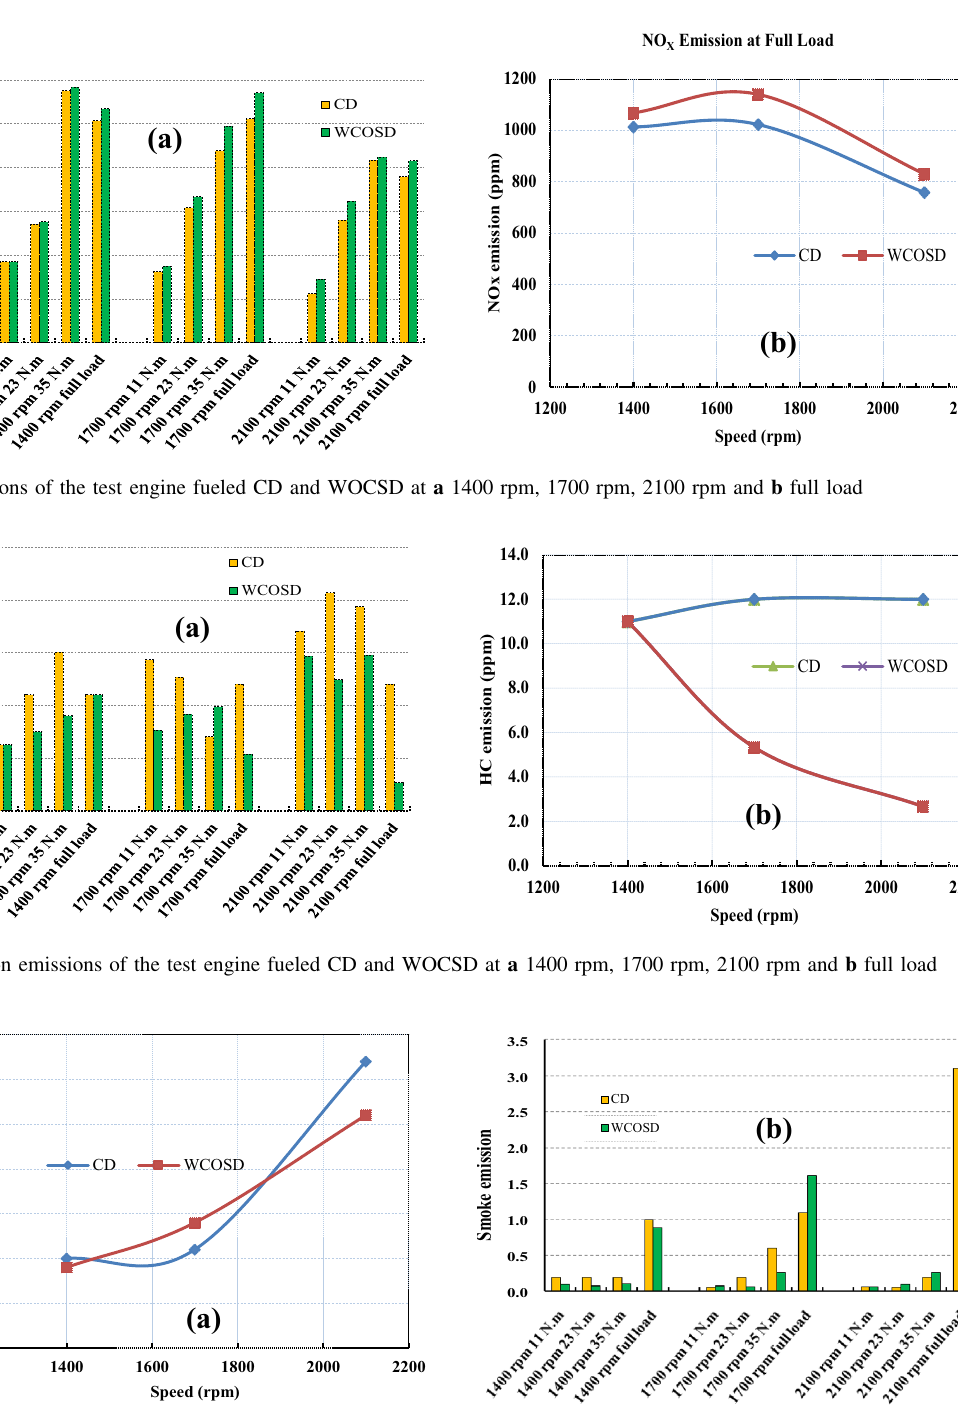
Fig. 10 Smoke emissions of the test engine fueled CD and WOCSD at a 1400 rpm, 1700 rpm, 2100 rpm and b full